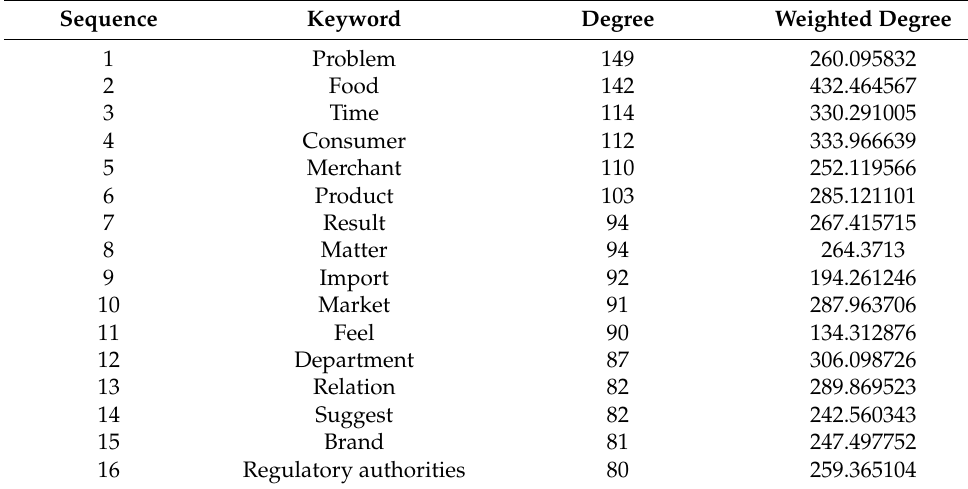
Table 11. The statistics of keyword degree